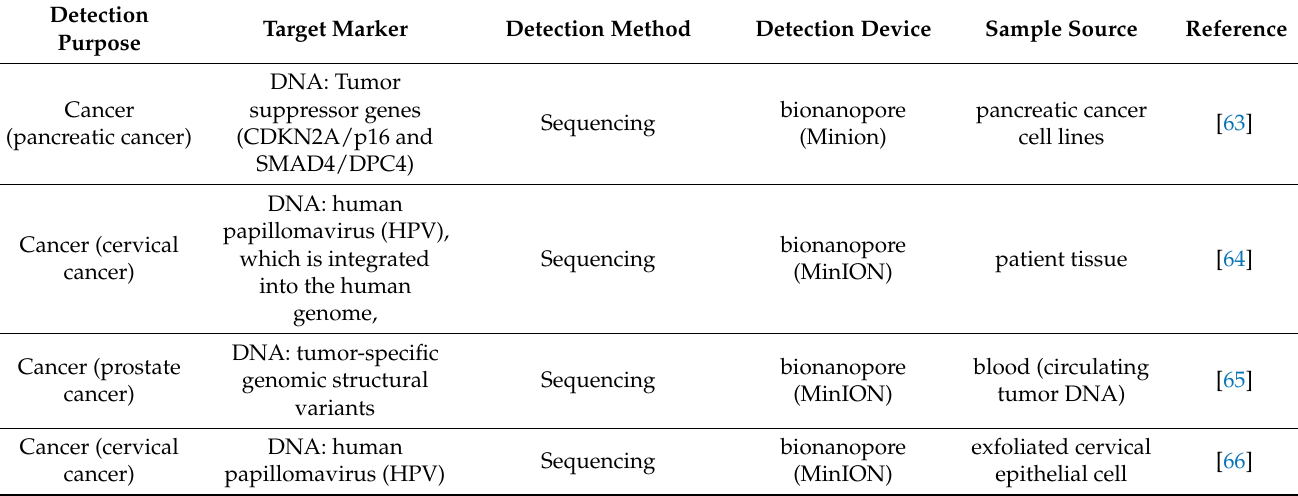
Table 2. Biological/medical application by single-molecule electrical measurement using